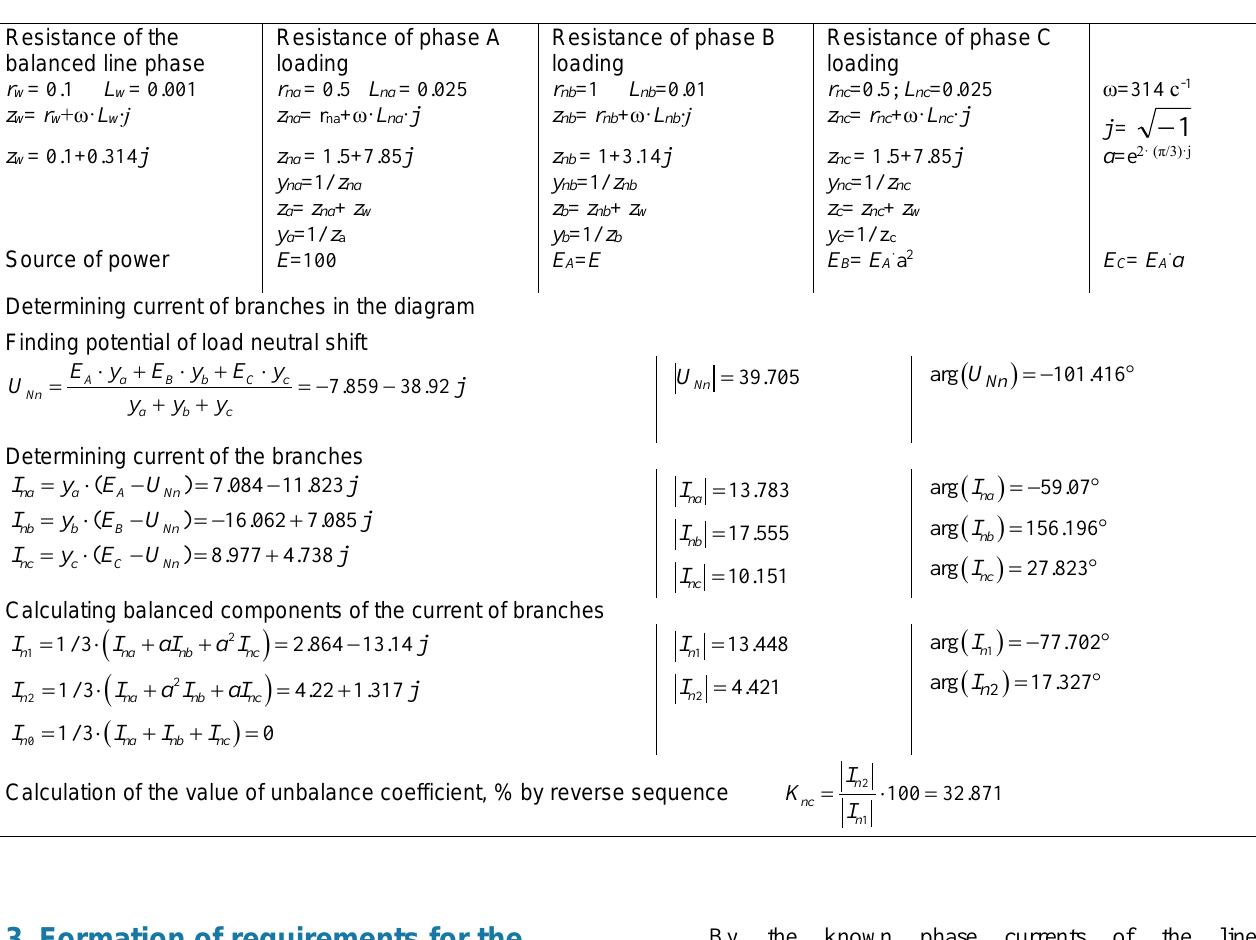
Table 1. Calculation of currents in equivalent diagram in Figure